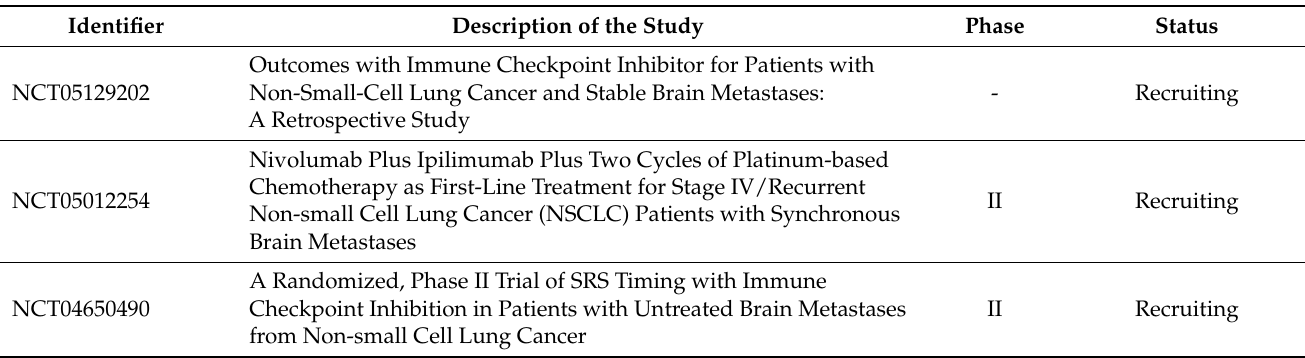
Table 3. Ongoing clinical trials in patients with NSCLC and